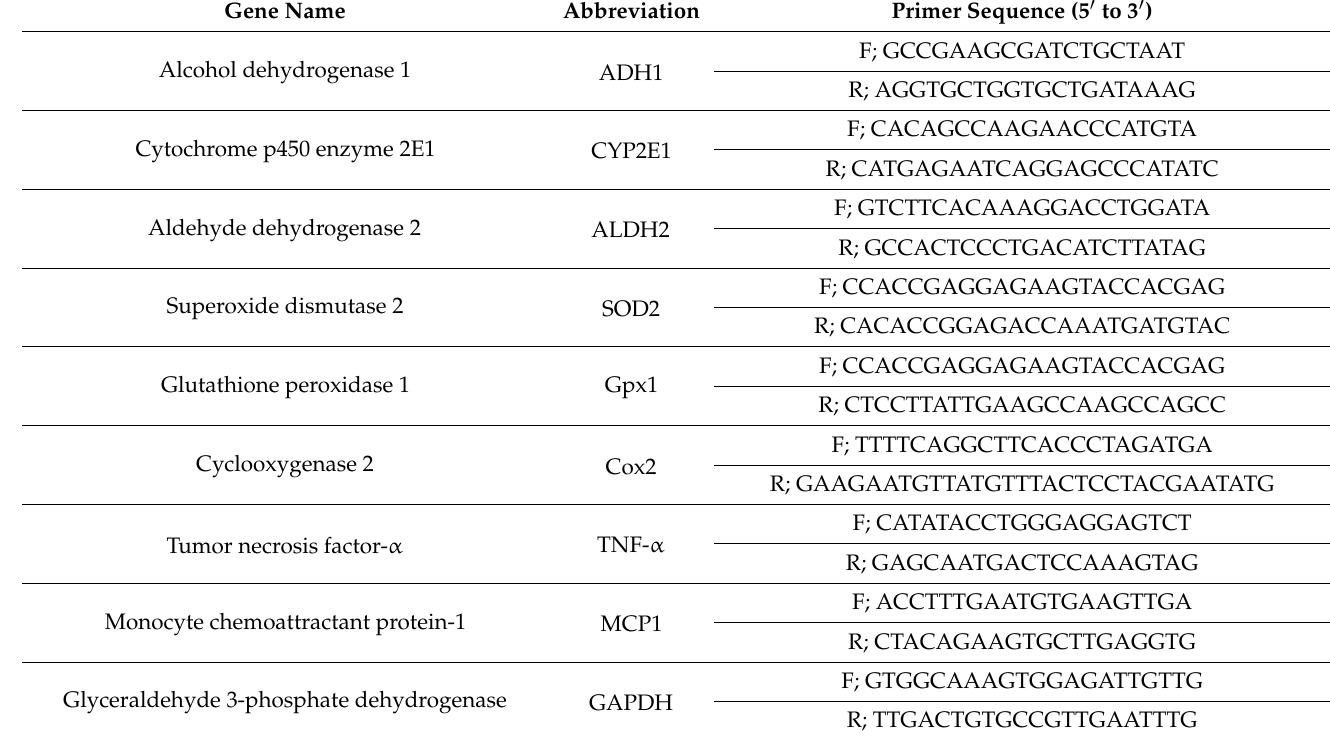
Table 1. List for genes and primers for RT-PCR